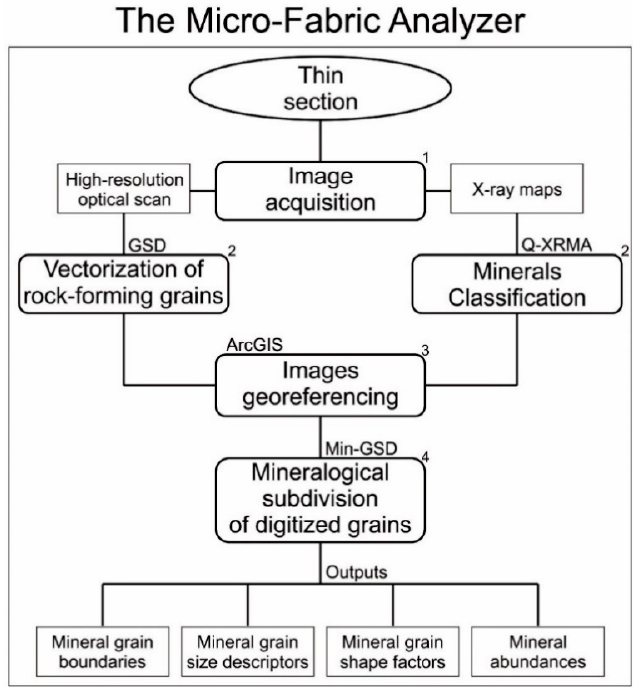
Figure 1. The workflow of the Micro-Fabric Analyzer.